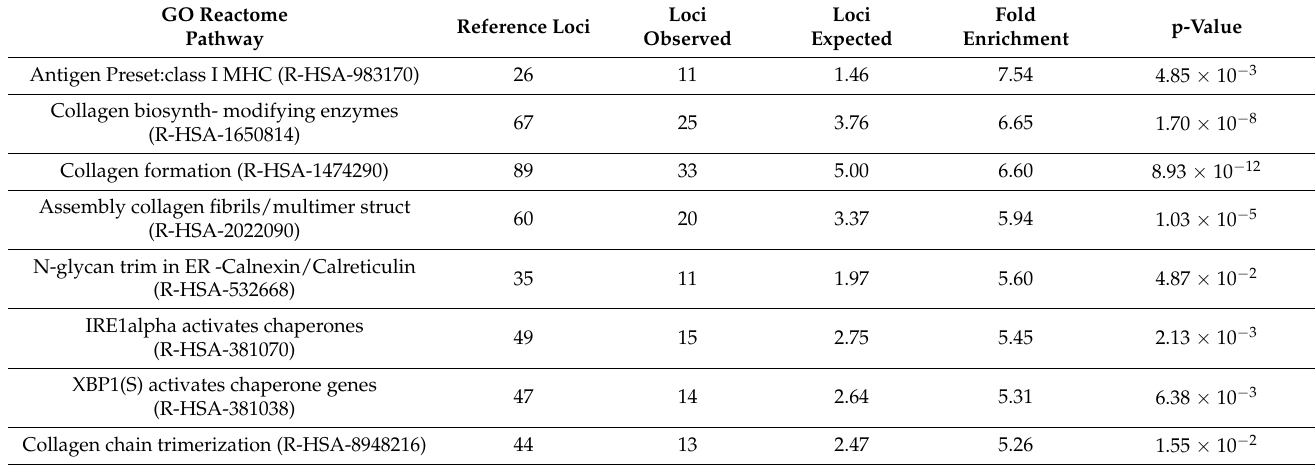
Table 4. GO reactome pathway analysis with Fisher’s exact test and Bonferroni correction showing the top eight hypoxia-upregulated pathways sorted by highest fold enrichment using all loci upregulated in hypoxia (n = 1261, p <